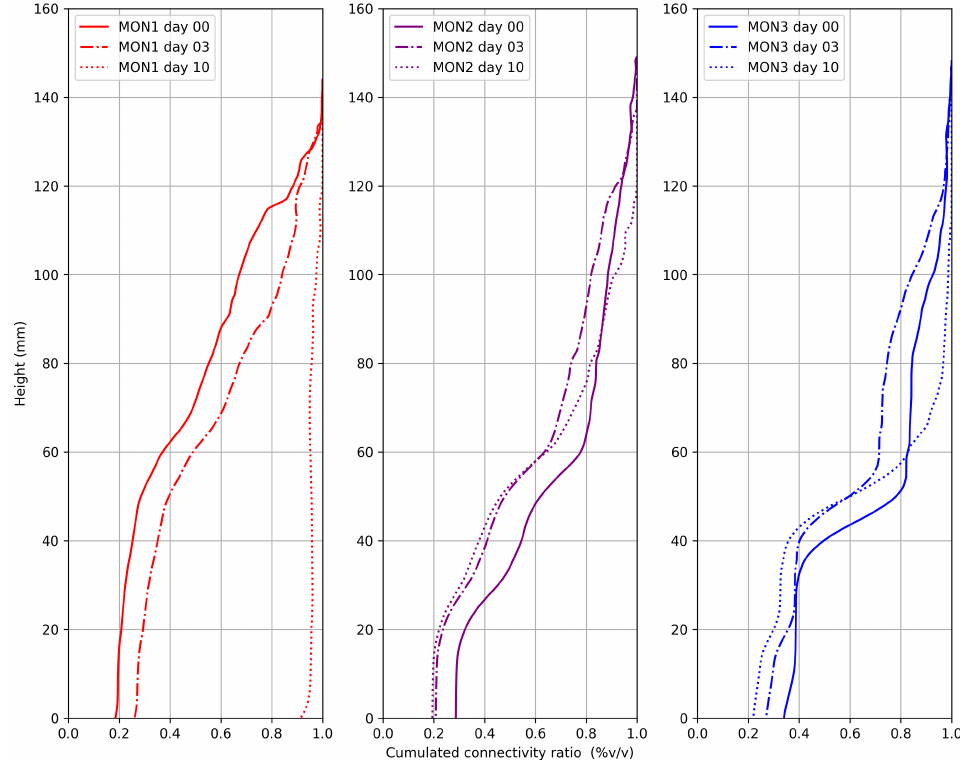
Figure 8. Cumulative void phase connectivity profiles: computations were performed for an ROI of